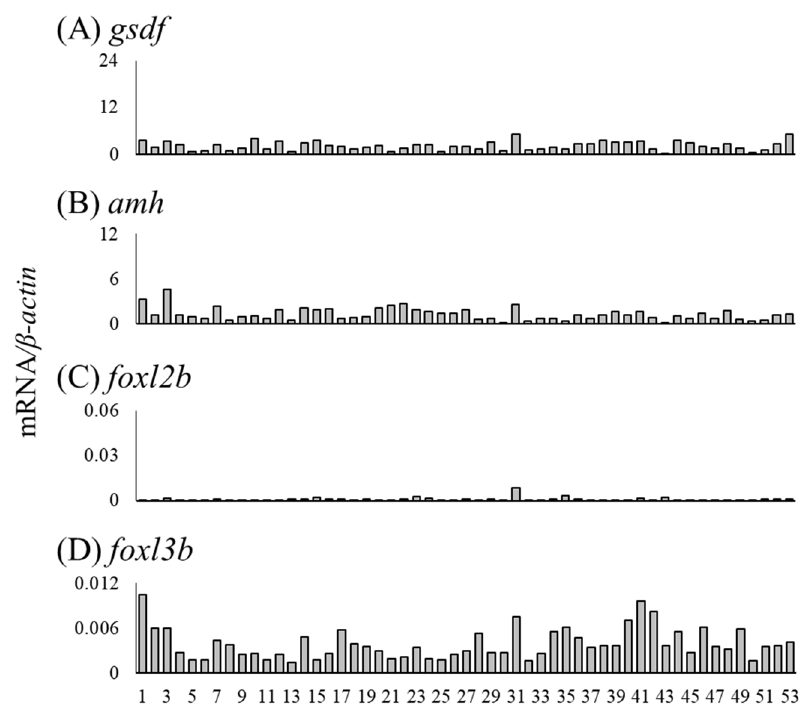
Figure 11. Messenger RNA levels of sex differentiation-related genes ( gsdf , amh , foxl2b and foxl3b ) in undifferentiated gonads of the wild Japanese eel Anguilla japonica. ( A ) gsdf , ( B ) amh , ( C ) foxl2b and ( D ) foxl3b mRNA levels in undifferentiated gonads. Each column indicates mRNA levels normalized against levels of β -actin . TL in undifferentiated gonads, including testis-like and ovary-like structures (Nos. 1–53); for details, see Table 5.